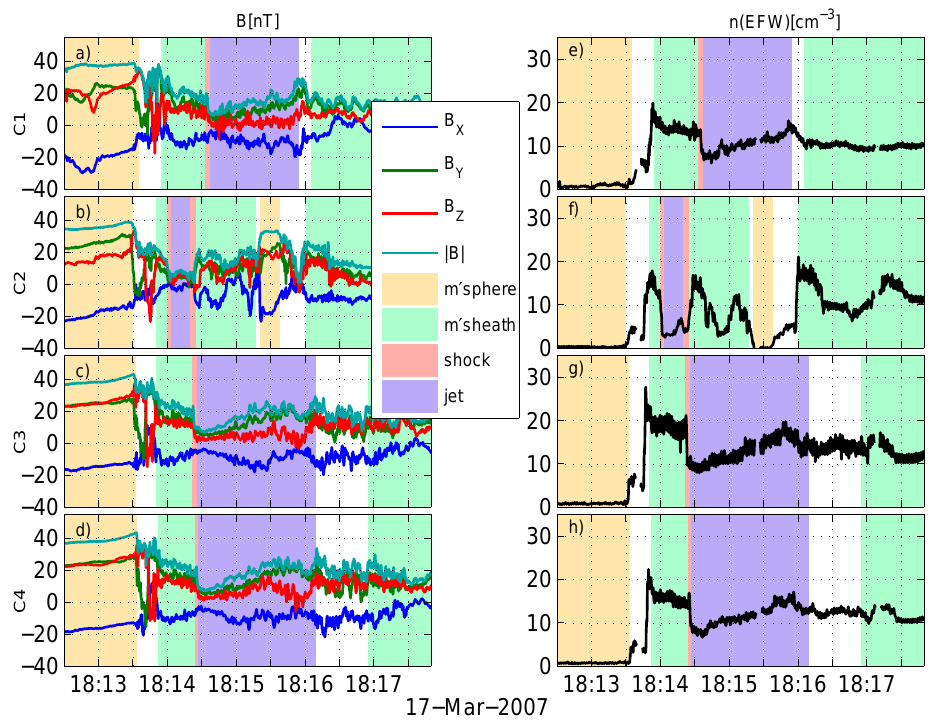
Fig. 4. Cluster observations near a supermagnetosonic magnetosheath jet. Left: magnetic field from all four spacecraft in GSE coordinates. Right: plasma density estimate based on a linear fit to the spacecraft potential measurements of the EFW instrument, using CIS-HIA ion and PEACE electron density measurements for calibration. CIS-HIA data were available only for C1 and C3. The colour panels mark different plasma regions. White background between colour panels represents transition between two regions. Panels (a–d) are from Hietala et al. (2009).